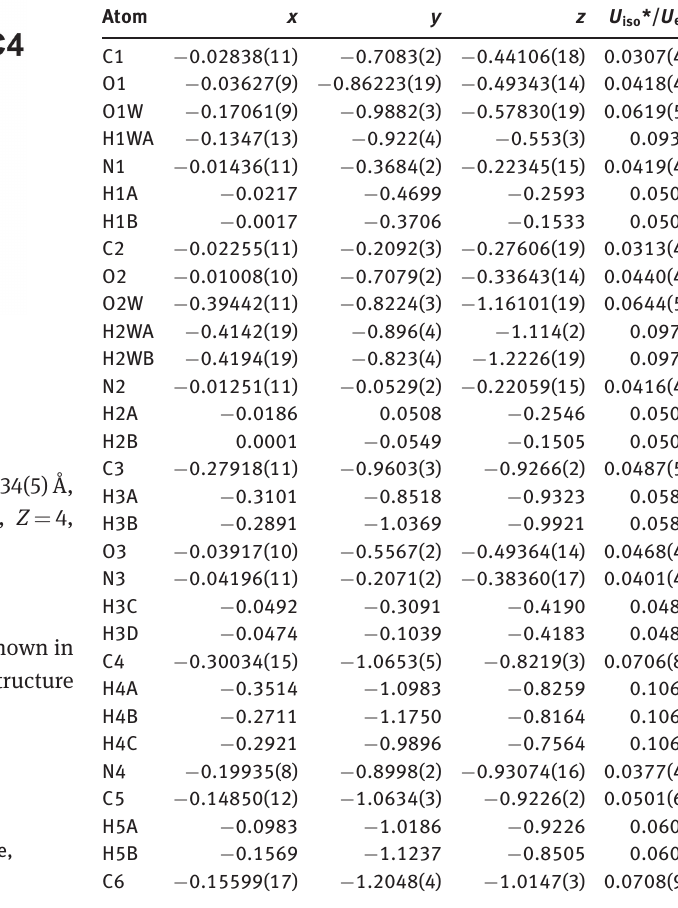
Table 2: Fractional atomic coordinates and isotropic or equivalent isotropic displacement parameters (Å 2